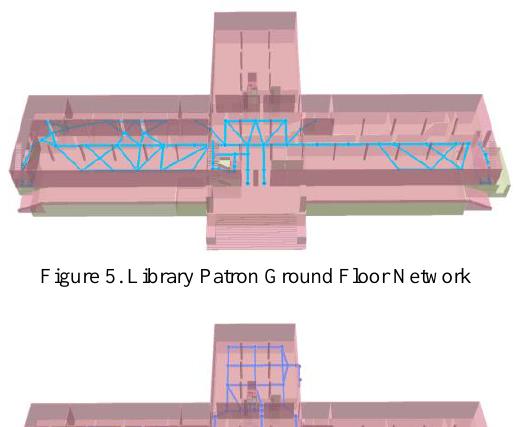
Figure 6. Library Staff Ground Floor Network